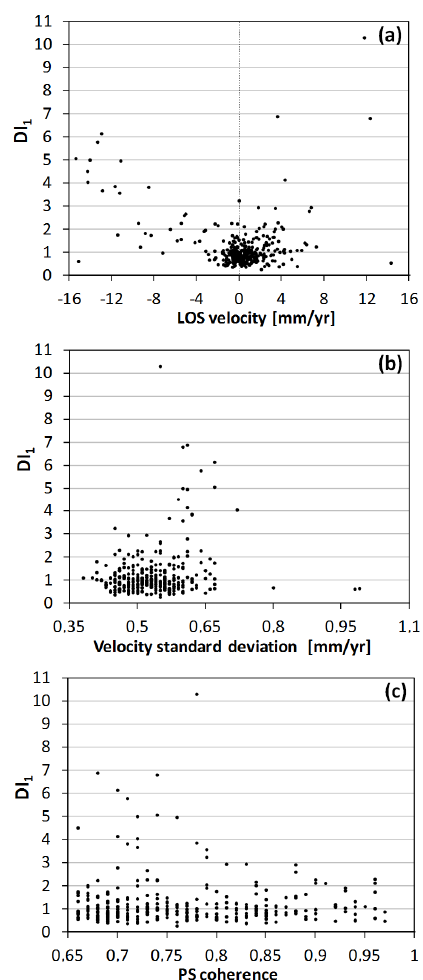
Fig. 10. Comparison of Deviation Index DI 2 with LOS velocity (a) , its standard deviation (b) and PS coherence (c) , for the PS time series of the test area of 2 with LOS velocity (a), its standard deviation (b) and 657 PS coherence (c), for the PS time series of the test area of Naro. 658